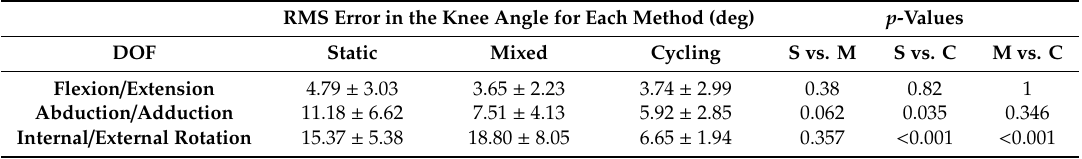
Table 4. Knee joint root mean squared (RMS) errors using each calibration method in comparison to the values obtained from the reference optoelectronic system and the ISB convention RMS Error in the Knee Angle for Each Method (deg) p -Values DOF Static Mixed Cycling S vs.